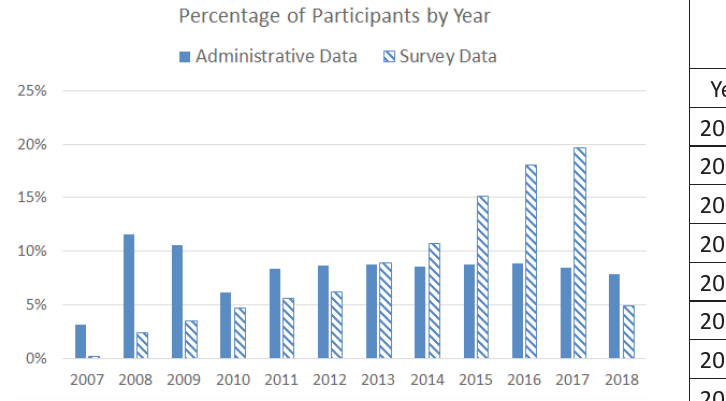
Figure 1: Participation in Forests Ontario Tree Planting Programs by year: administrative data (n=6,238) versus survey respondents